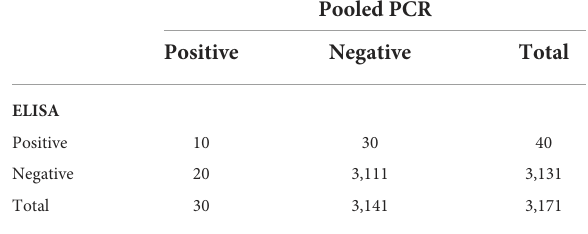
samples (k = 0.26) (Table B in Supplementary Material). Two- TABLE 2 Comparison of MAP testing results for ELISA testing of serum samples as compared to PCR testing of pools of five fecal samples for 3,171 samples from beef cows examined with two diagnostic